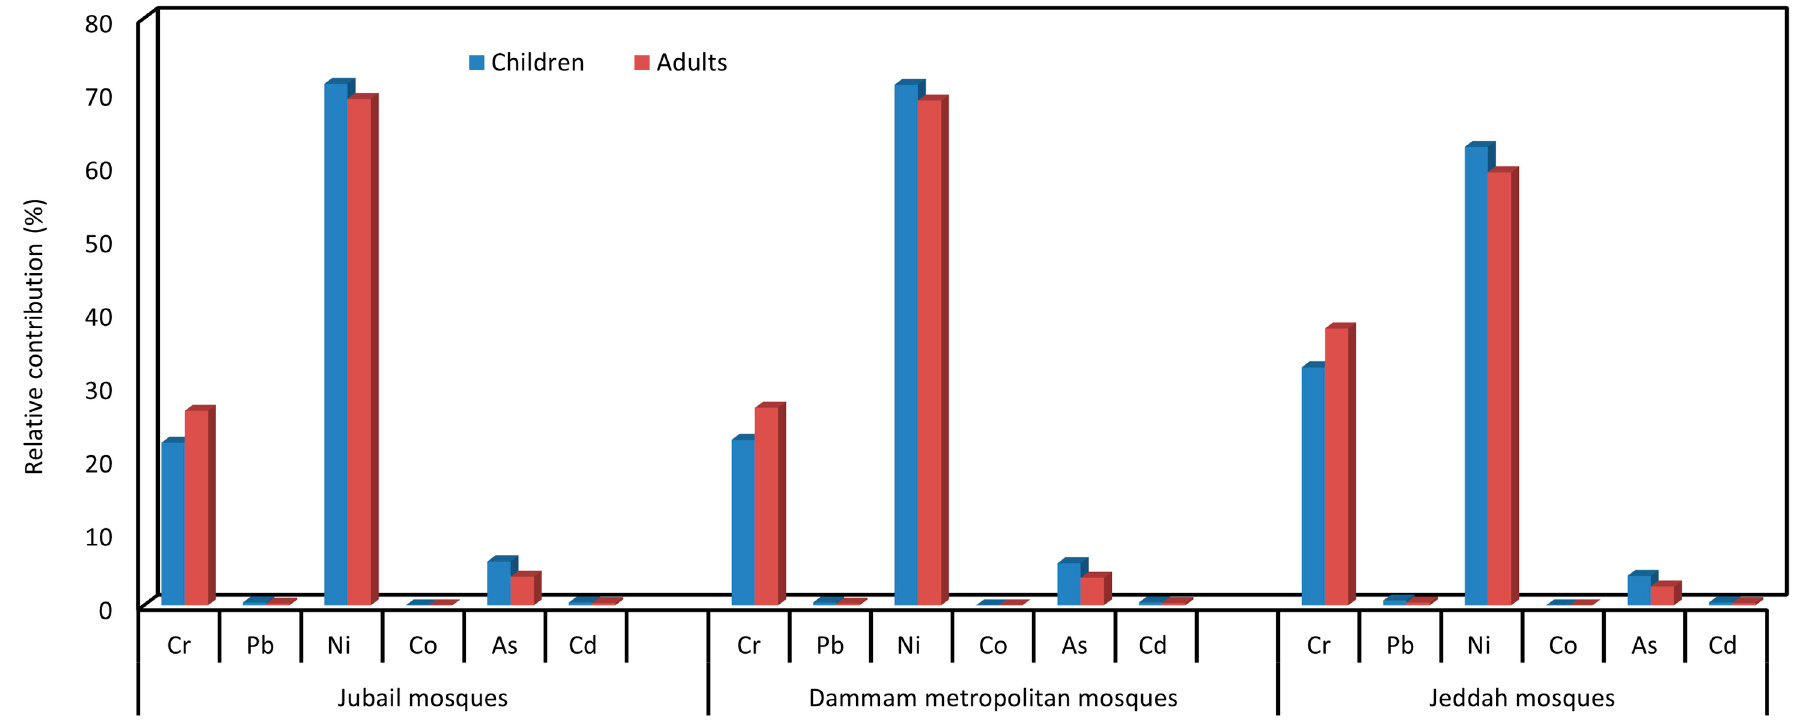
Figure 8. Relative contribution of the individual PHE cancer risk (CR) to ∑ CR for total PHEs in Jubail, Dammam metropolitan, and Jeddah mosques for children and adults.